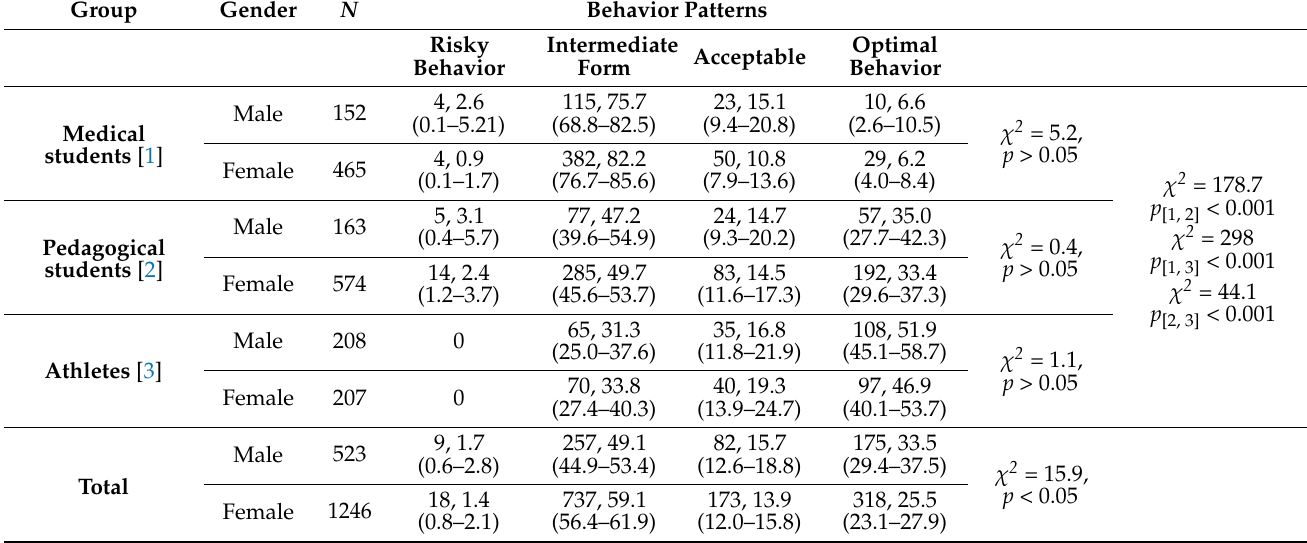
Table 9. Models of student behavior depending on the gender group ( n , %; 95%